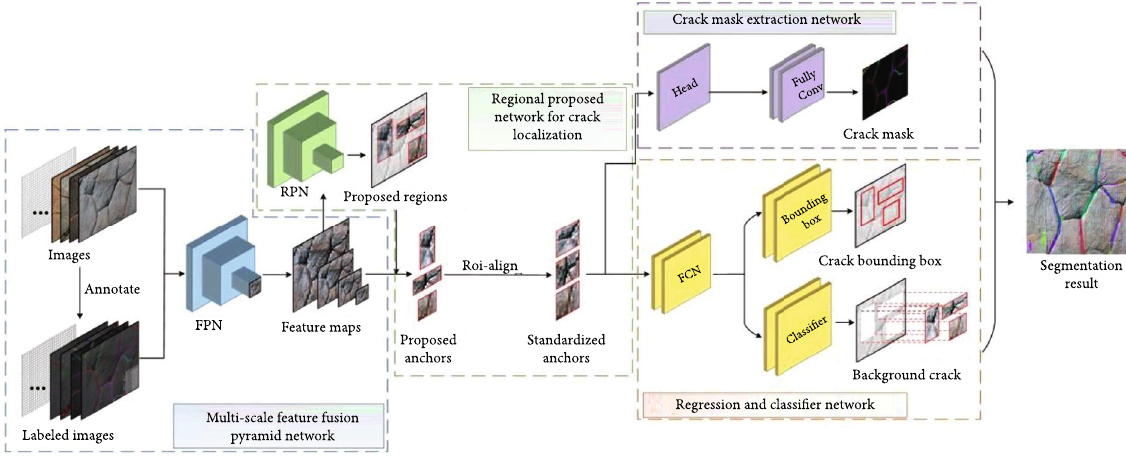
Figure 6: Detection framework of